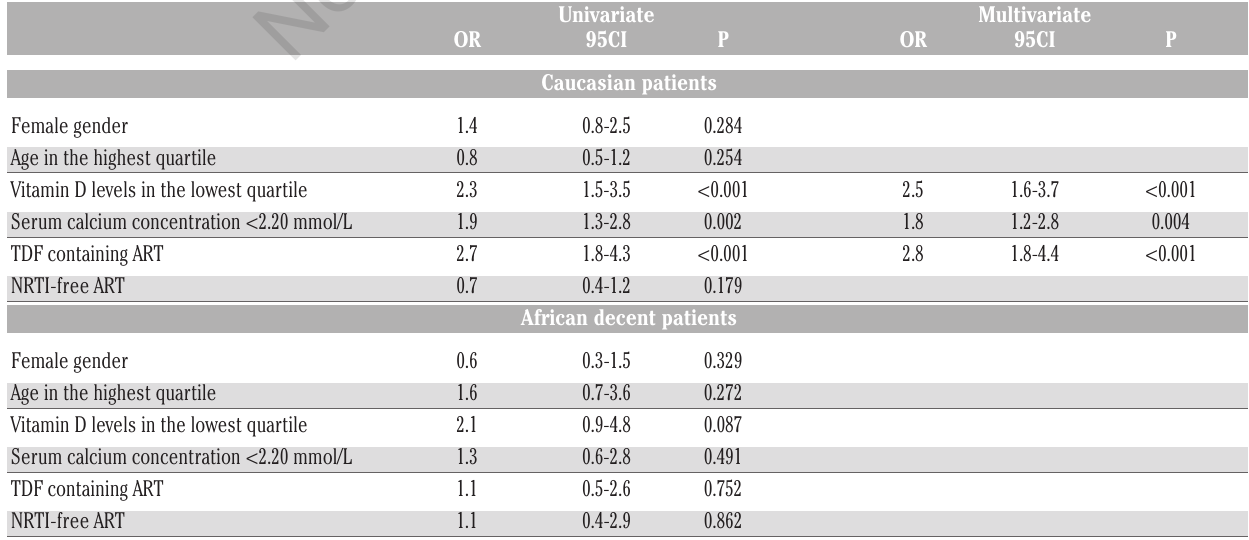
Table 2. Association of different binary factors on the occurrence of elevated PTH in uni- and multivariate logistic regression analysis analyzed per